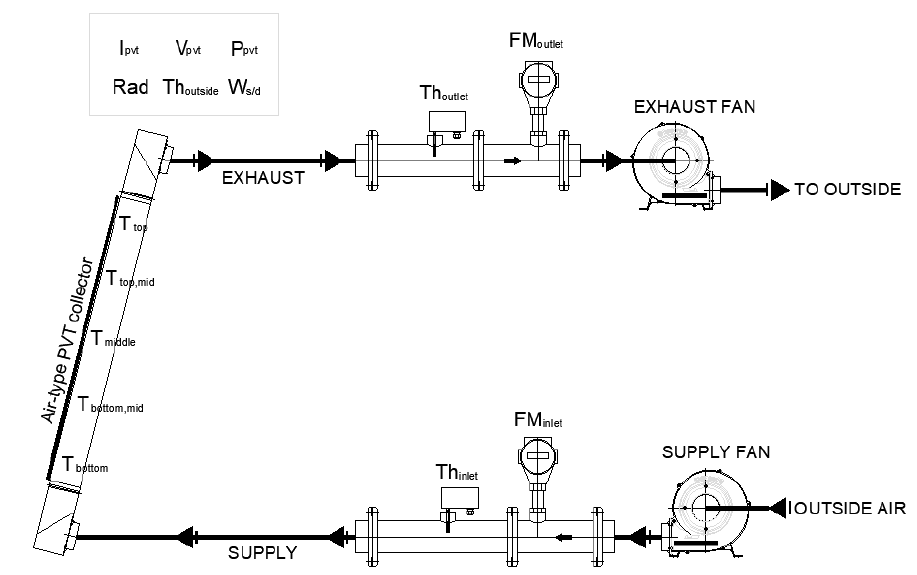
Figure 3. Installation for air-type PVT collector Experiment.